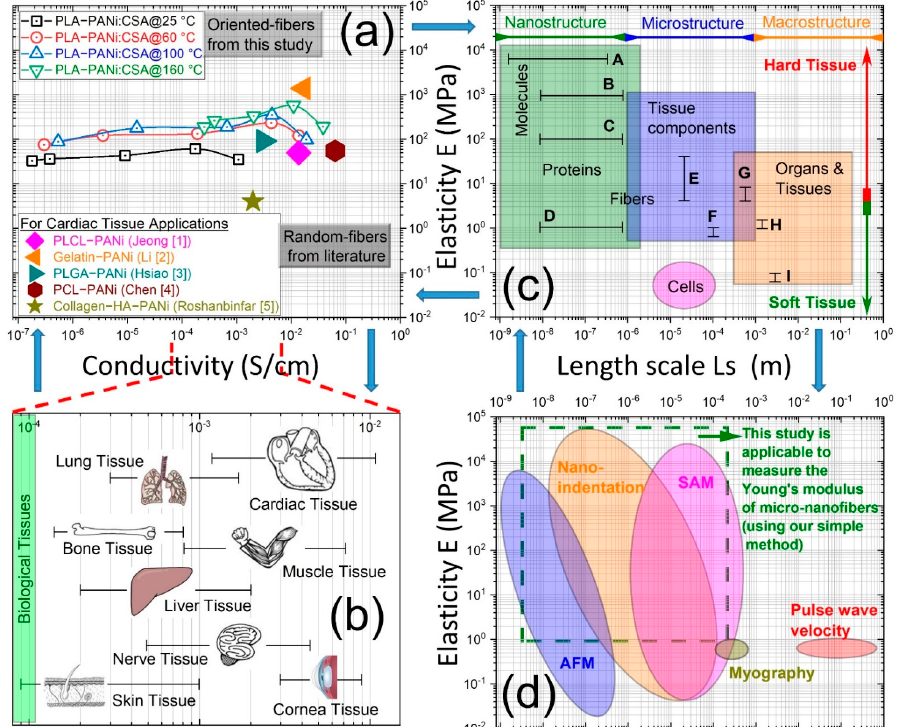
Figure 7. ( a ) shows a comparative study comparing the conductivities and Young’s moduli (elastic- ity) of our fabricated highly aligned conductive PLA-PANi:CSA fibers with other random